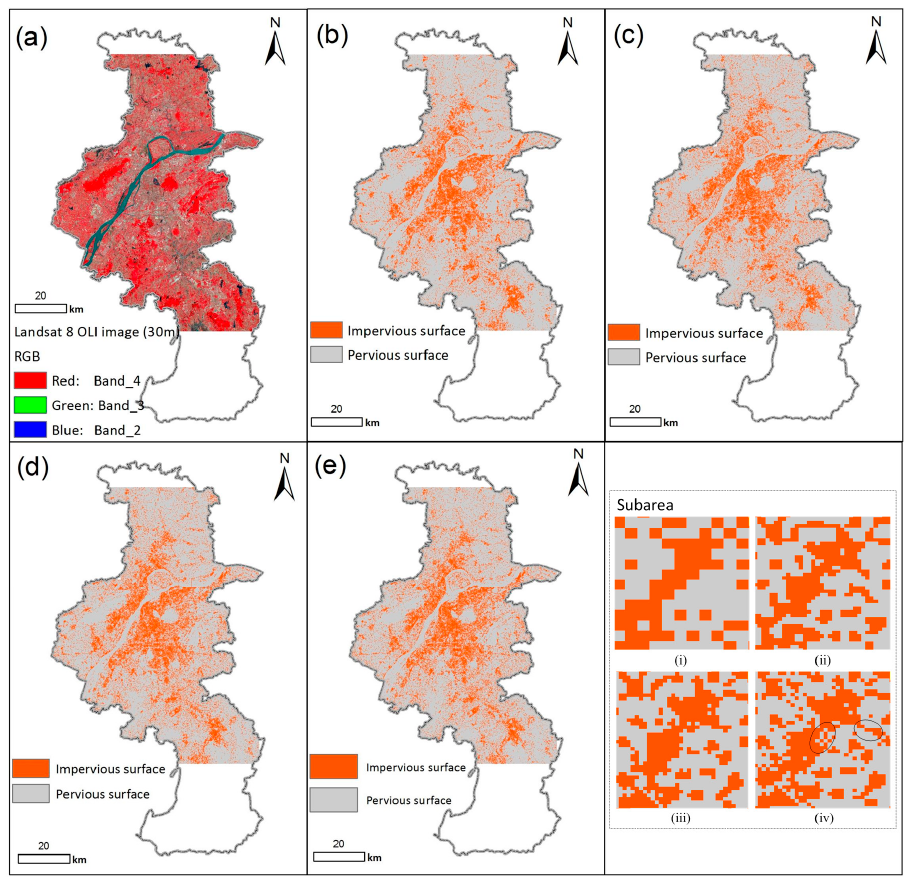
Figure 5. Experimental results using a Landsat 8 OLI image. ( a ) Landsat 8 OLI image (30 m); ( b )